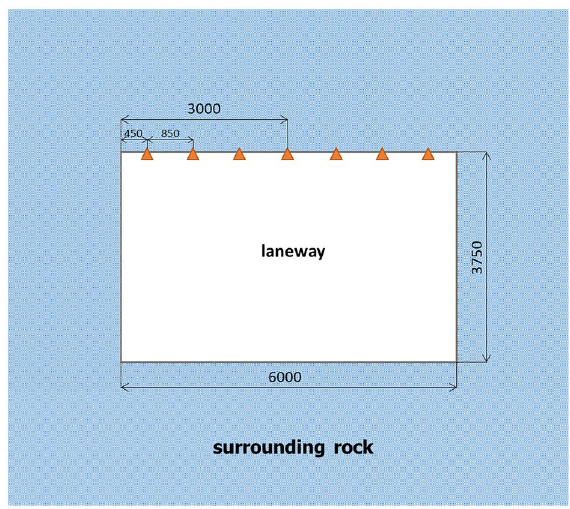
Figure 10. Schematic of roadway section monitoring site locations.